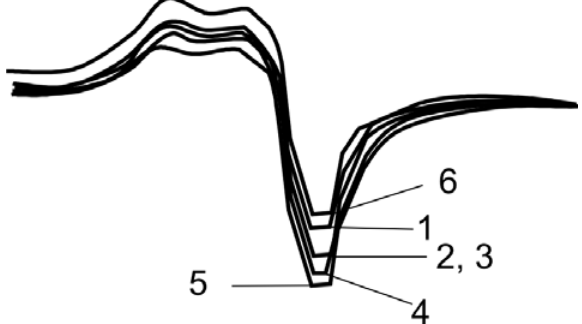
Figure 17. Cu 2+ (I) of the super conducting Y nanocomposites with SHMPE. Curve 2—1% SHMPE; Curve 3—3% SHMPE; Curve